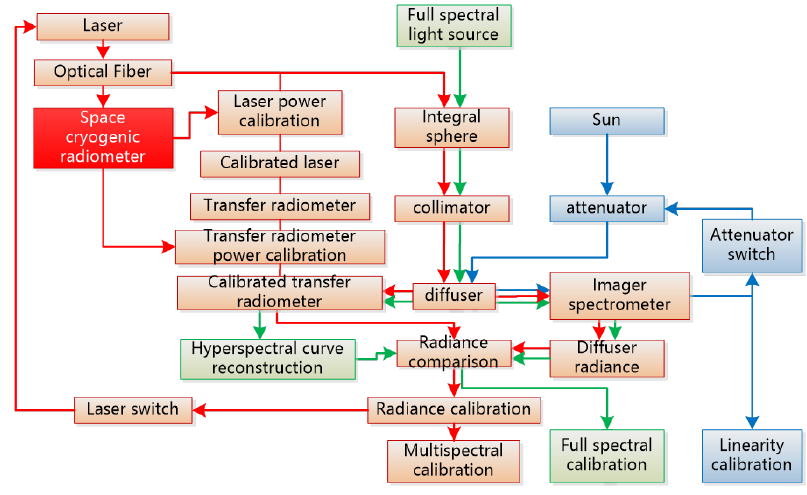
Figure 4. Principle of the benchmark transfer chain (BTC).